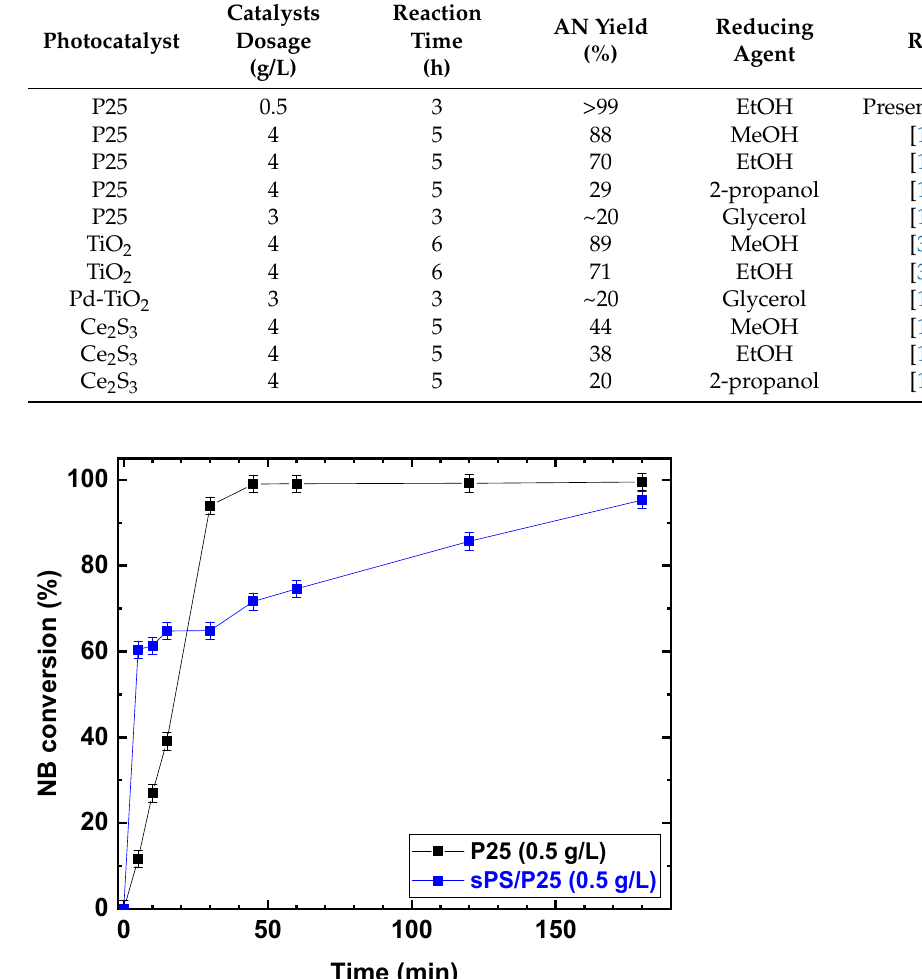
Figure 8. Effects of the initial NB concentration on AN yield, AN selectivity, and NB conversion. UV irradiation time t is 45 min. Error bar ± 5%. Table 1. Comparison with the available literature for photocatalytic conversion of NB.